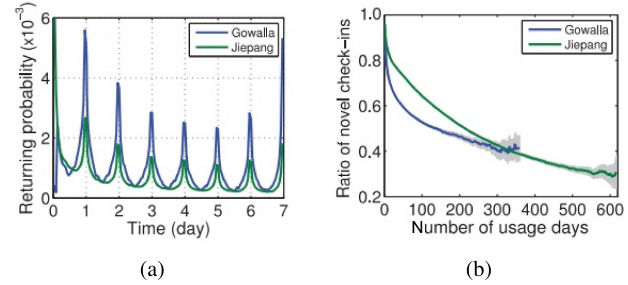
Fig. 7 (a) Probability of return; (b) ratio of novel check- in locations to all check-in locations in Gowalla and Jiepang datasets [48]